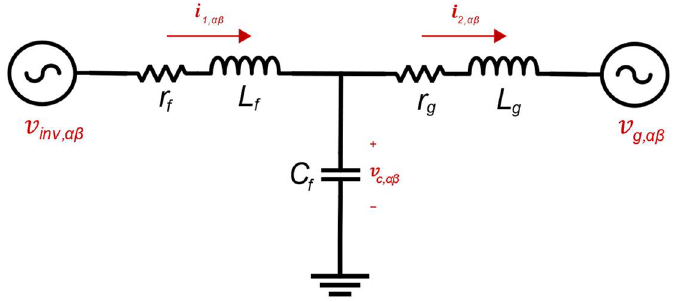
Figure 5. LCL filter single line